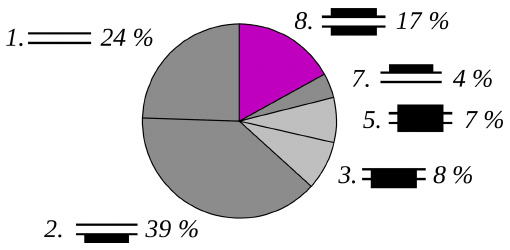
Figure 7. Non-seeding cases. Cloud categories of all non-seeding subsaturated layers. “In between” refers to the subsaturated layer. “Above” and “below” refer to the supersaturated layers above or be- low the subsaturated layer. A total of 100% equals all non-seeding subsaturated layers. Non-seeding is calculated using a hexagonal plate of initial size r = 400µm. The values are rounded to zero dec- imal places.